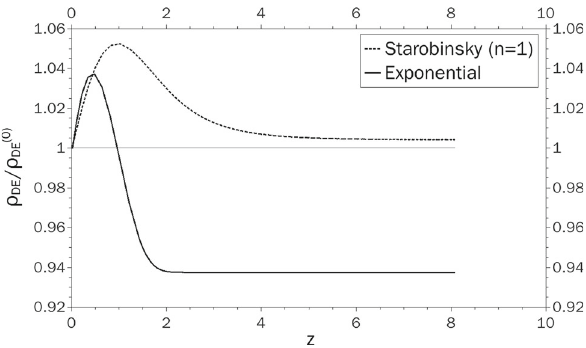
Fig. 1 ρ DE /ρ ( 0 ) as functions of the redshift z with ρ DE 0 ) , where the solid and dashed lines represent the exponential and Starobinsky gravity models with λ − 1 e = 0 . 56 and (λ − 1 s , n ) = ( 0 . 28 , 1 ) , respectively, while H 0 = 67 . 8 ( km / s · Mpc ) and the initial condition is ((cid:9) m ,(cid:9) r ,(cid:9) DE ) = ( 0 . 306 , 7 . 88 × 10 − 5 , 0 . 694